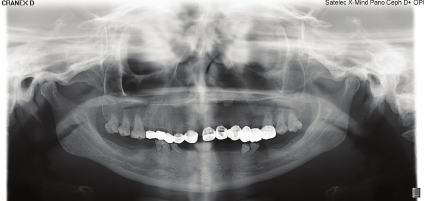
Figure 5: Extraoral photographs.